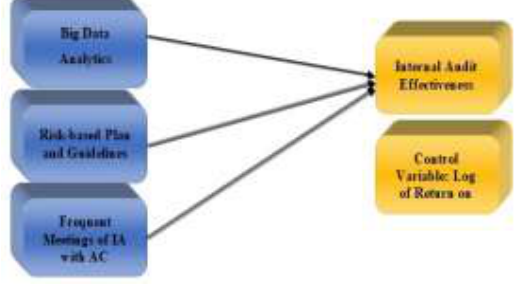
Figure 1. Model Framework